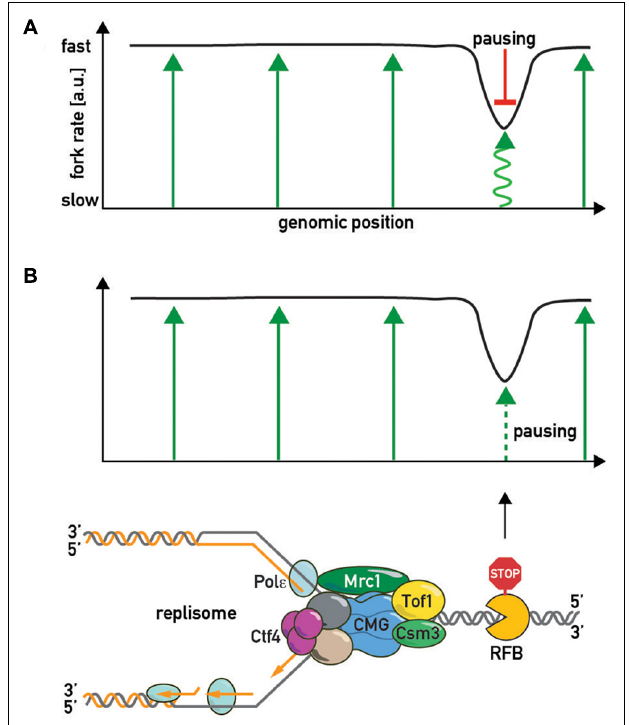
FIGURE 5 | The “slowing-centric” and “acceleration-centric” replisome progression models. Green arrows—fork acceleration. Pausing is either a separate active process with a dominant effect over acceleration [ (A) red inhibitory bar line] or results from local loss of acceleration function [ (B) smaller dashed green